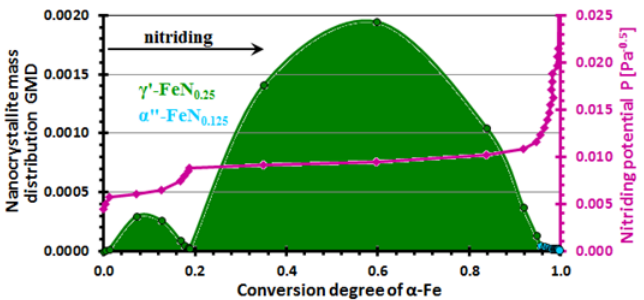
Figure 6. The dependencies of distribution of nanocrystallite size and nitriding potential on the degree of the conversion of nanocrystalline α - Fe(N) to γ’ -FeN 0.25 .